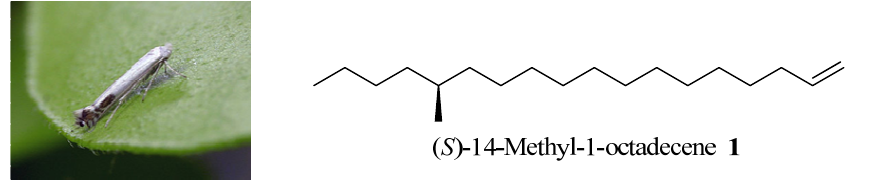
Figure 1. Peach leafminer moth and the chemical structure of its sex